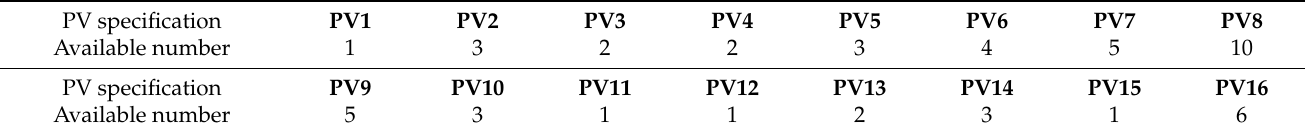
Table 5. Assumption of available procurement numbers for each PV specification.